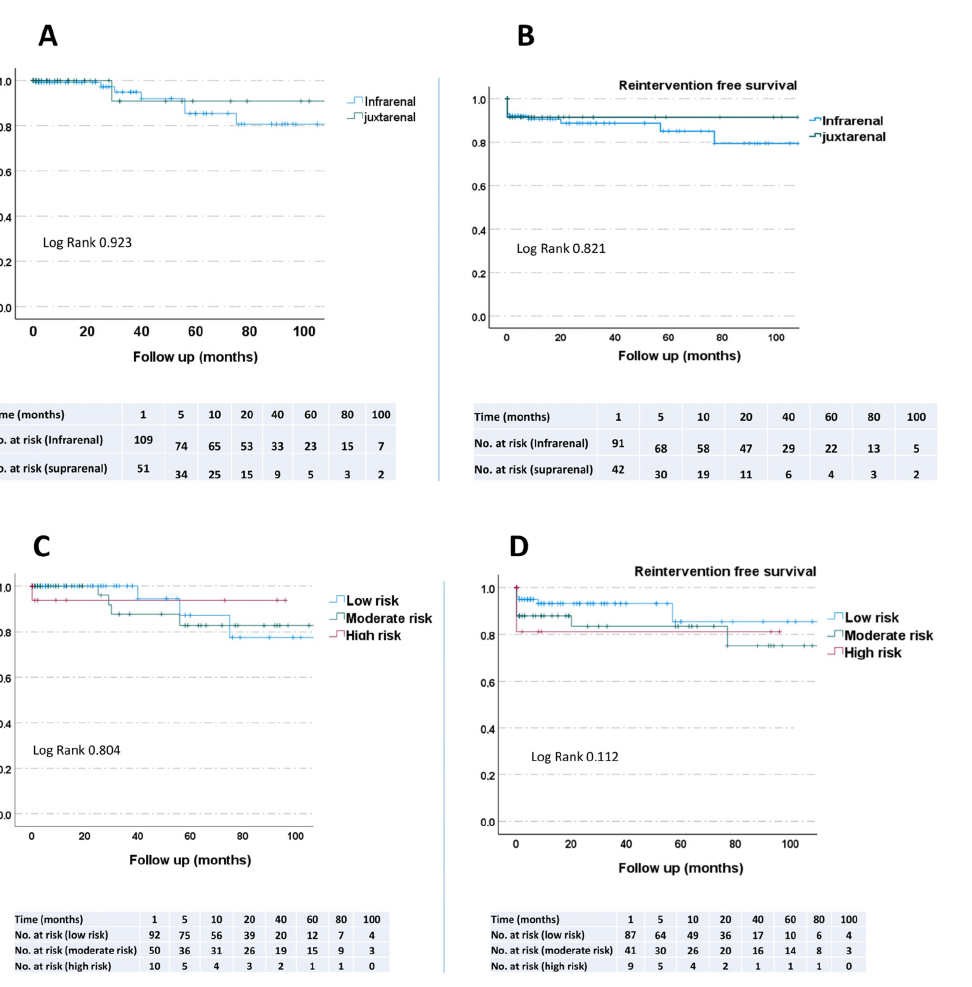
Figure 1. Kaplan–Meier survival and reintervention estimates showed no significant difference between the groups. ( A , B ) Patients stratified into two groups: infrarenal aneurysm ( n = 137) and juxtrarenal aneurysm ( n = 77). ( C , D ) Patients were stratified into three groups according to the surgical risk (Medicare Aneurysm Scoring System): low risk ( n = 137), moderate risk ( n = 61), and high risk ( n =